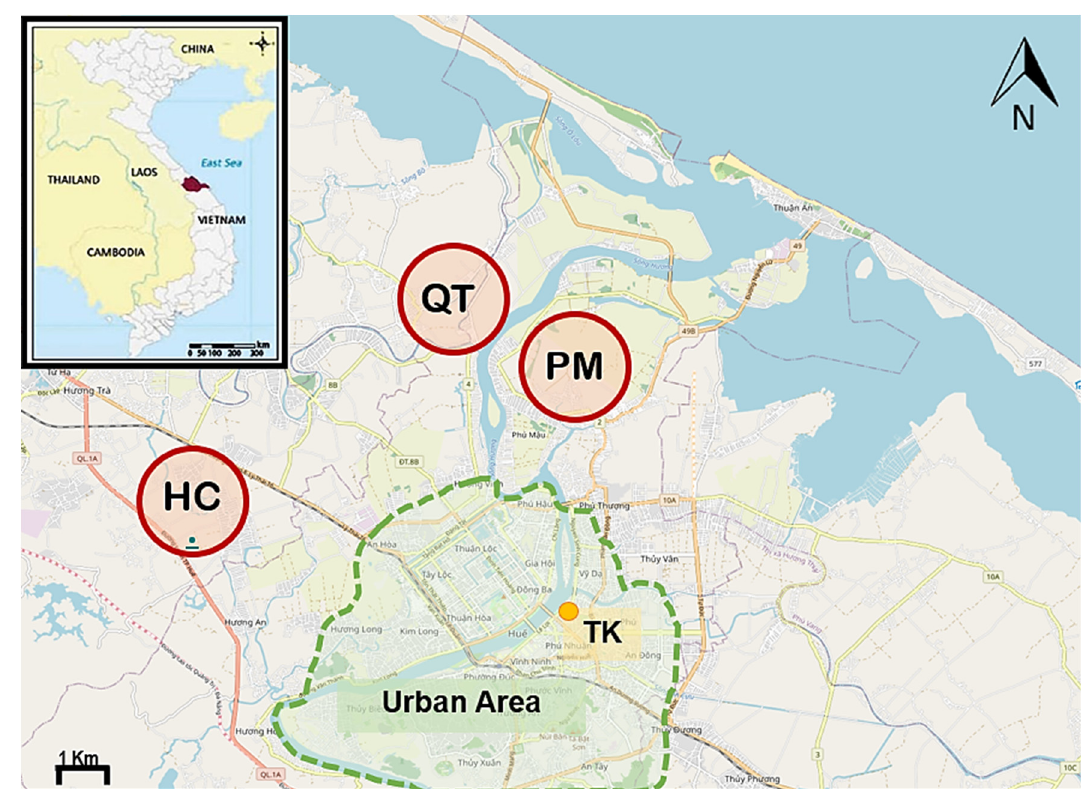
Figure 1. Location of sampling in Hue, Vietnam. Irrigation water (IRW), soil (SOL), and manure (MNR) samples were taken from Huong Chu (HC), Phu Mau (PM), and Quang Thanh (QT) communes in red circles. Municipal wastewater (MWW) samples were collected from the drainage pipe at Toa Kham (TK) (orange dot). The light-green shaded area shows extent of the city; however, only the northeast section drainage flows through TK.